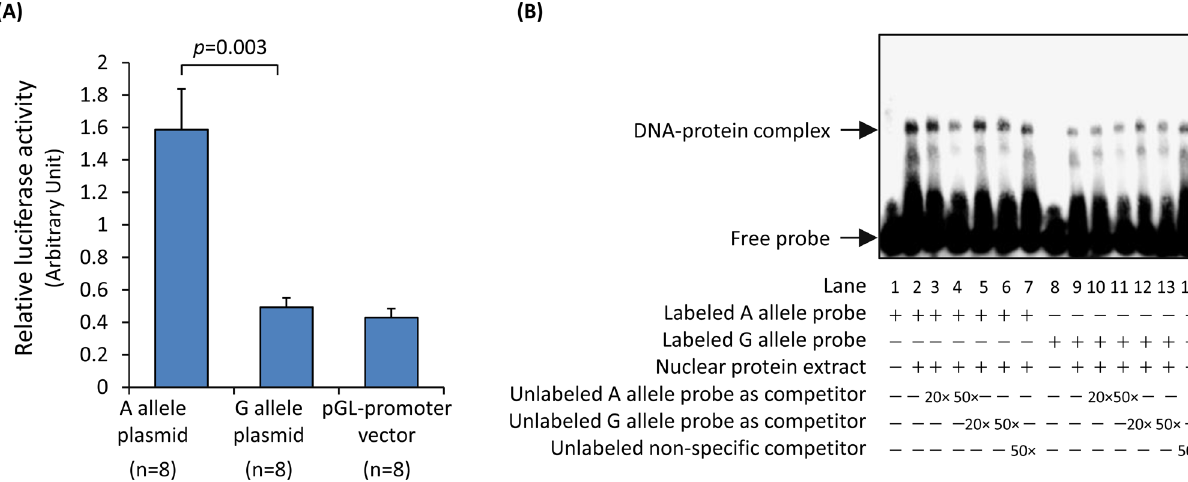
Fig 3. Effect of SNP rs4773144 on transcription modulating activity of a DNA sequence encompassing the SNP and on nuclear protein interaction with the DNA sequence. (A) Vascular SMCs were transfected with a firefly luciferase reporter gene plasmid (pGL3-promoter vector) with an insert corresponding to a DNA sequence encompassing the rs4773144 site of the A or G allele, or with the empty plasmid (control), together with a plasmid (pRL-TK) containing a renilla luciferase gene to serve as a transfection efficiency reference. At 48 hour after transfection, activities of firefly luciferase and renilla luciferase were measured. Columns and error bars represent mean and SEM values of the ratio of firefly luciferase activity to renilla luciferase activity. (B) A representative image of electrophoretic mobility shift assays. Nuclear protein extracts from vascular ECs were incubated with biotin-labeled probes corresponding to the A allele (lanes 1 – 7) or the G allele (lanes 8 – 14) of SNP rs4773144 in the absence or presence of competitors in 20-fold or 50-fold molar excess, as indicated underneath the